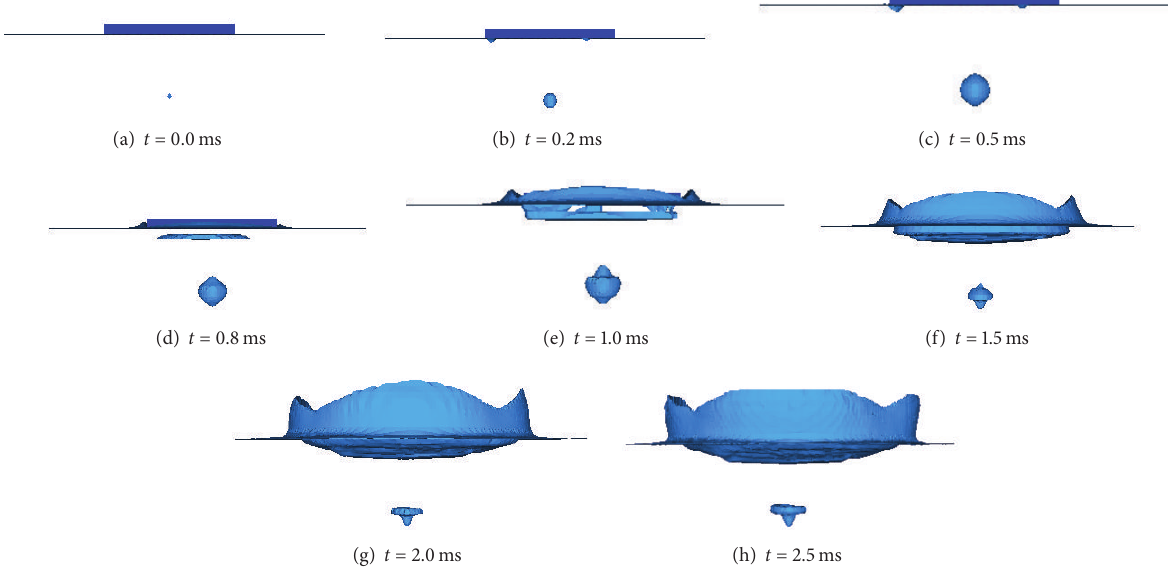
Figure 9: Bubble shape state of case 1 ( W = 0.05 kg, d =